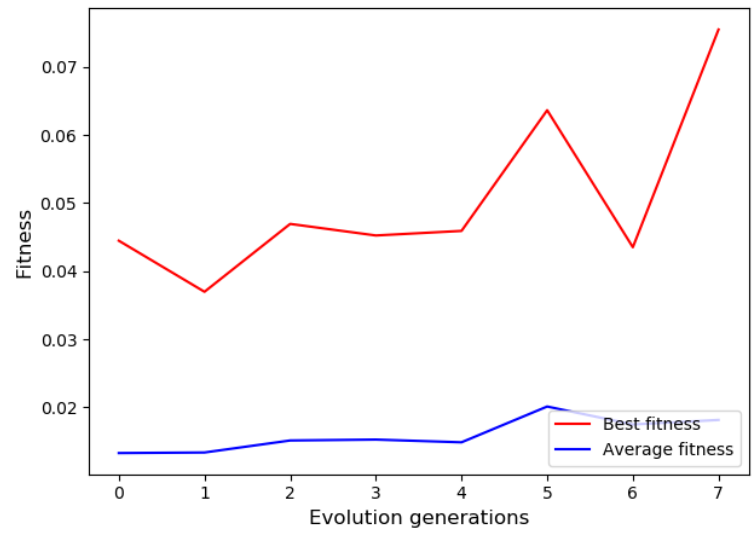
Figure 2. Convergence curve of the corrosion rate prediction model.